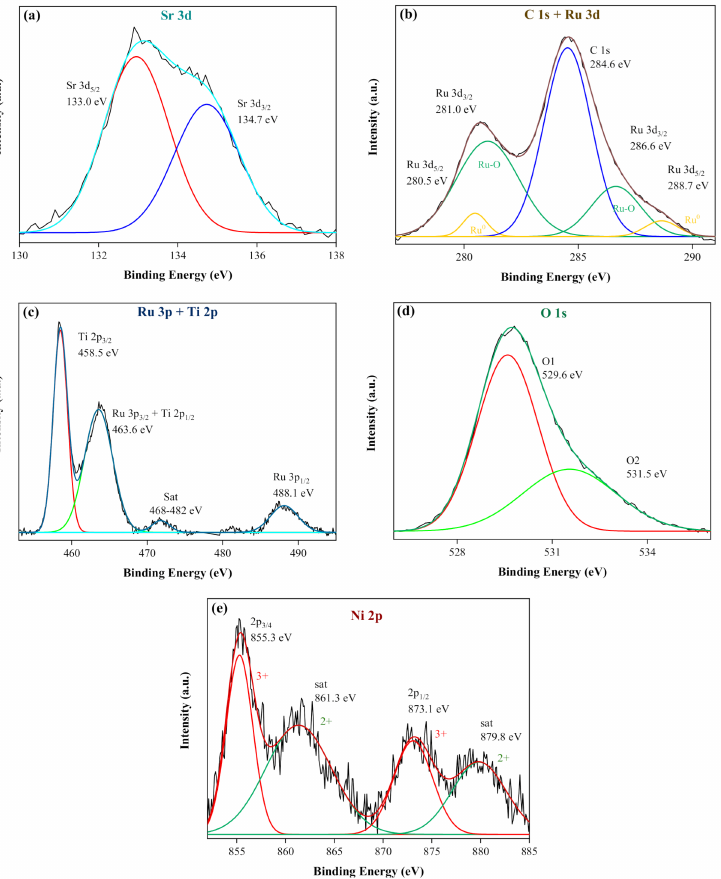
Figure 5. High-resolution XPS spectra of the ( a ) Sr 3d, ( b ) C 1s + Ru 3d, ( c ) Ru 3p + Ti 2p, ( d ) O 1s, and ( e ) Ni 2p occupied states recorded for the SrTiO 3 :RuO 2 :NiO photocatalyst (0.8 wt.% of Ru; [Ru]:[Ni] molar ratio of 1:1), along with the respective fitting and deconvolution